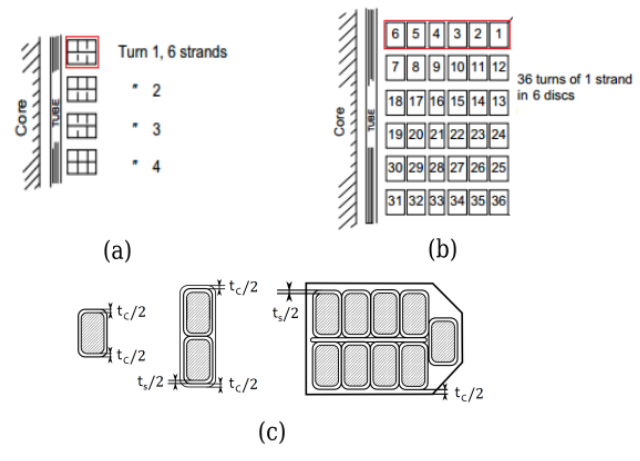
Figure 3. Typical winding arrangements: ( a ) a helical winding with 6 parallel strands in one turn ( b ) a disc winding from 1 strand. Typical winding materials ( c ): single conductor, axial twin, continuously transposed cable